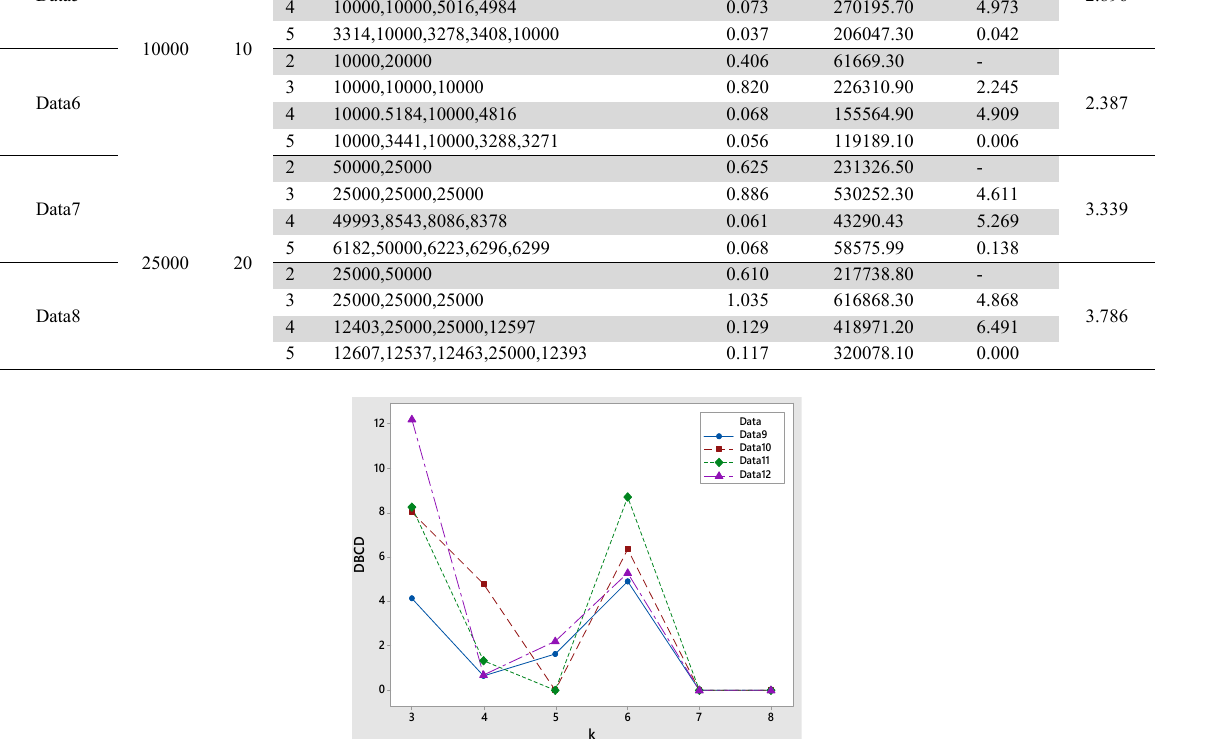
Fig. 6. Scatter plot for distance between cluster centroids (DBCD) vs k for Data9-Data12 Clustering results for Data9-Data12 with 5 clusters